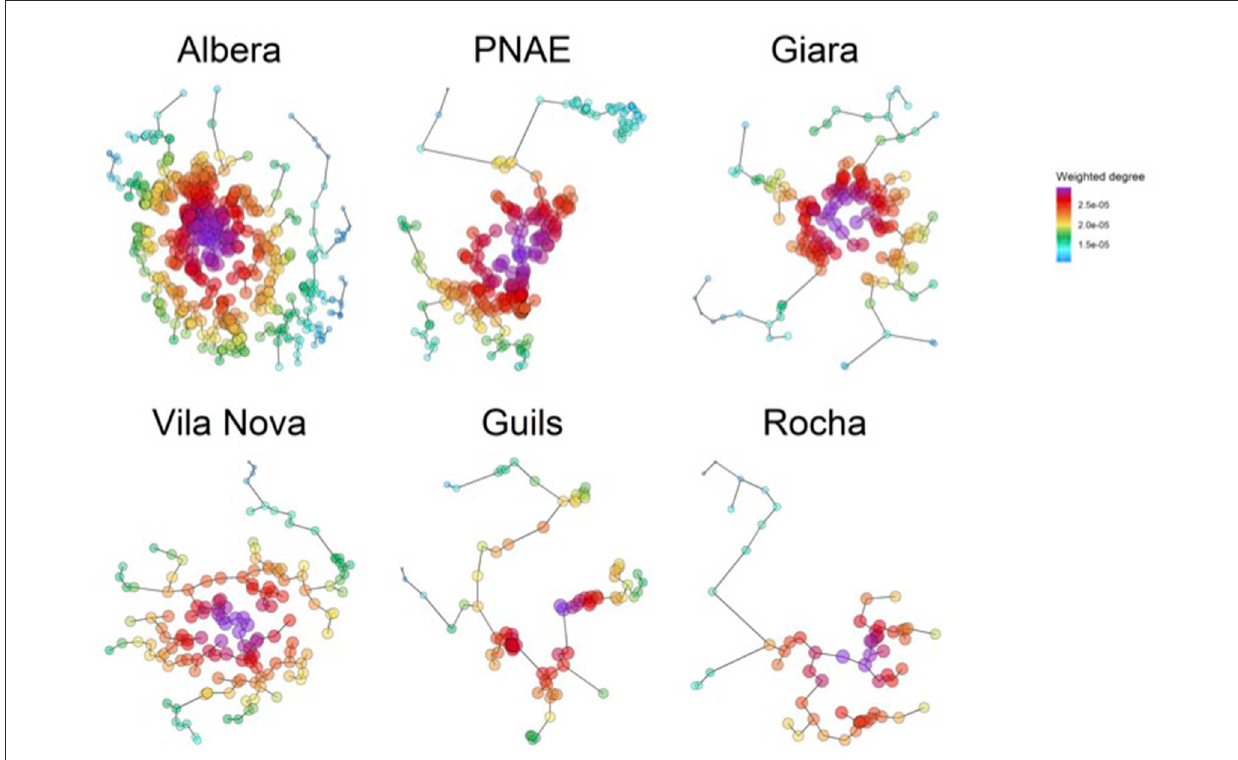
FIGURE1 Pondscapes analyzed in this study. Five European pondscapes [Albera, Clots de Guils, Empordà Wetlands (PNAE) and Vila Nova de Milfontes] and one Uruguayan (Rocha). Minimum spanning trees (the network that connects all nodes with a minimum of links) are presented for visualizing the spatial arrangement of